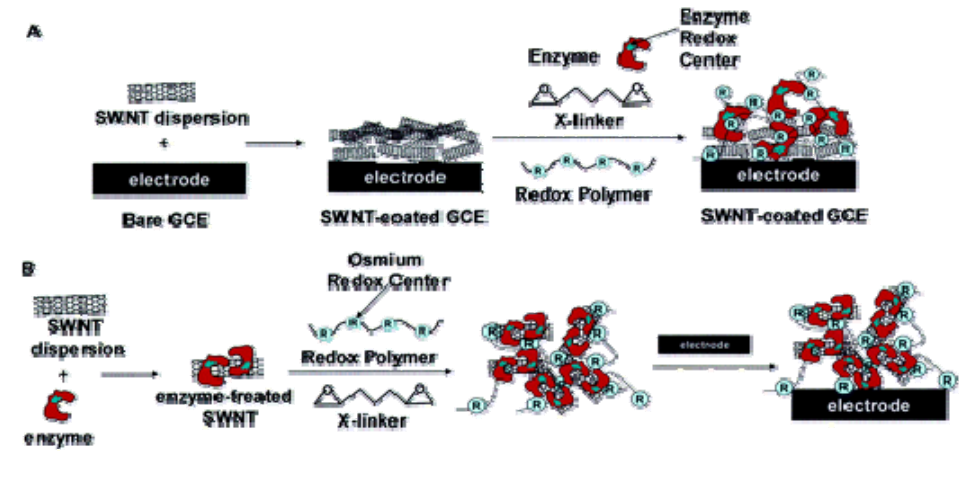
Figure 4. Schematic of the construction of type A and type B sensors. (A) Fabrication of type A sensors in which a film of SWNTs was first cast onto a bare glassy carbon electrode and allowed to dry, before an alquot of the redox hydrogel was cast on top of the SWNT- coated electrode. (B) Fabrication of type B sensors in which SWNTs were first incubated with an enzyme solution before they were incorporated into the redox hydrogel. An aliquot of the redox hydrogel solution containing the enzyme-modified SWNTs was then cast on top of a bare glassy carbon electrode